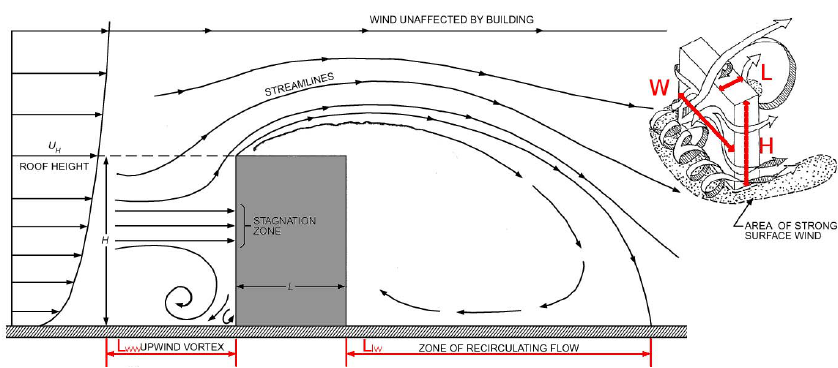
Fig. 2. Schematic view of the recirculation zones of the wind flow around obstacles. Figure reproduced with modifications from Kuehn and Coleman